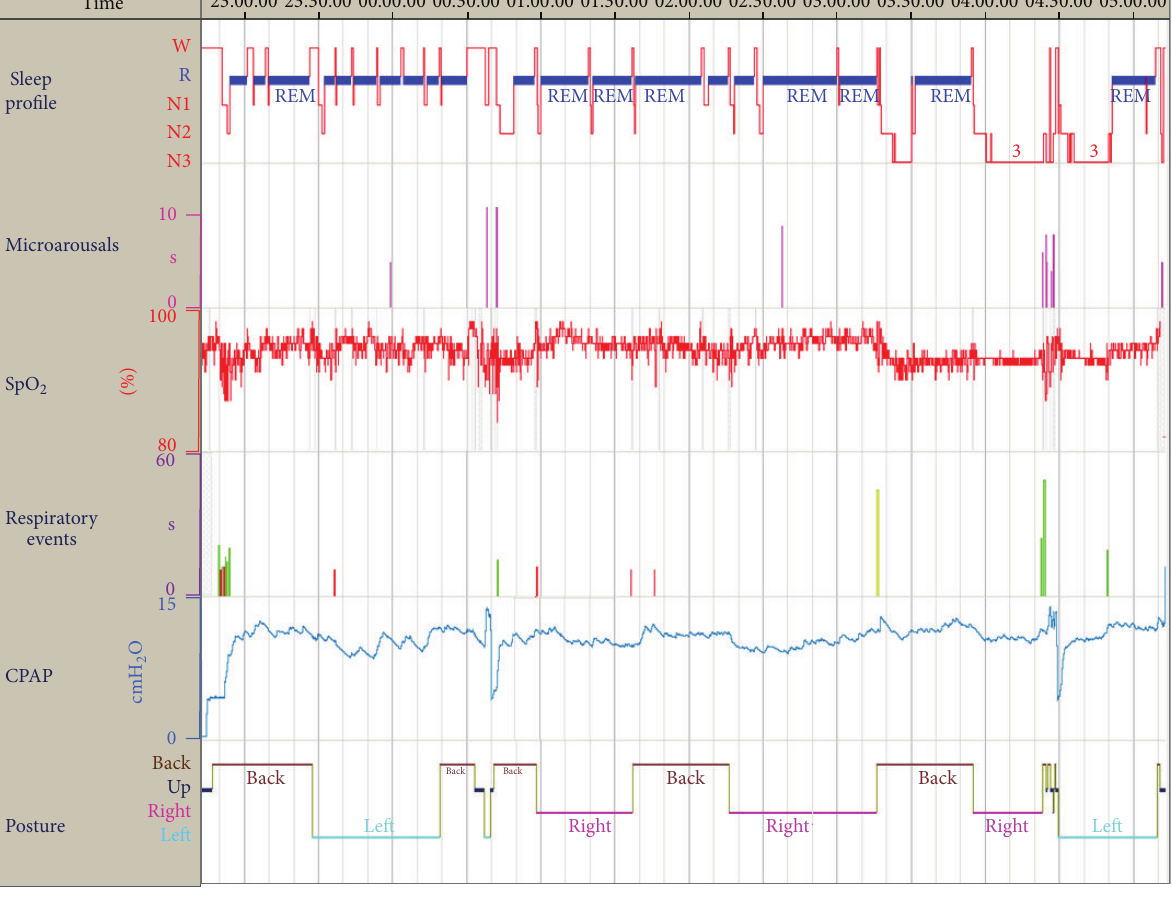
Figure 1: Analysis of the nocturnal polysomnography during automatic CPAP titration. From top to bottom: hypnogram, microarousals, oxyhemoglobin saturation, respiratory events (brown: flow limitations, green: hypopneas, and red: central apneas), CPAP level, and body